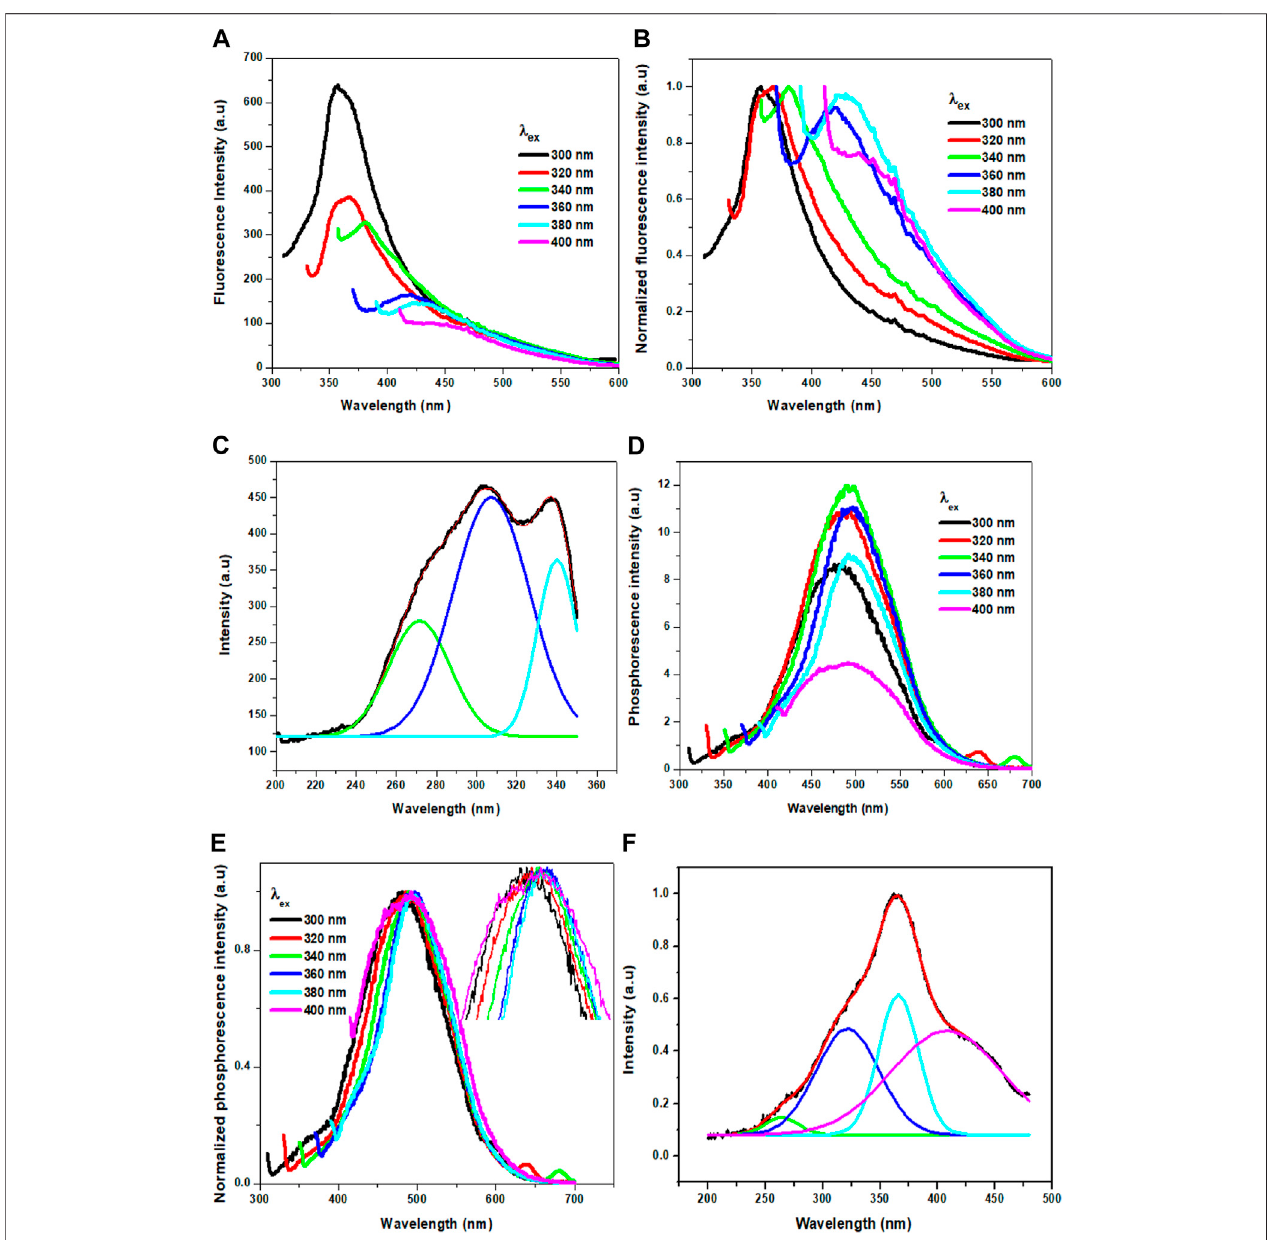
FIGURE5|(A) FluorescenceofCl-CNDs(solidstate)withavariationofexcitationwavelengthfrom300to400 nm (B) correspondingnormalizedspectraof (A) . (C) FluorescenceexcitationspectraofCl-CNDsmonitoredunder360 nmemissionwithdeconvolutionshowingthemultiplepeaks. (D)